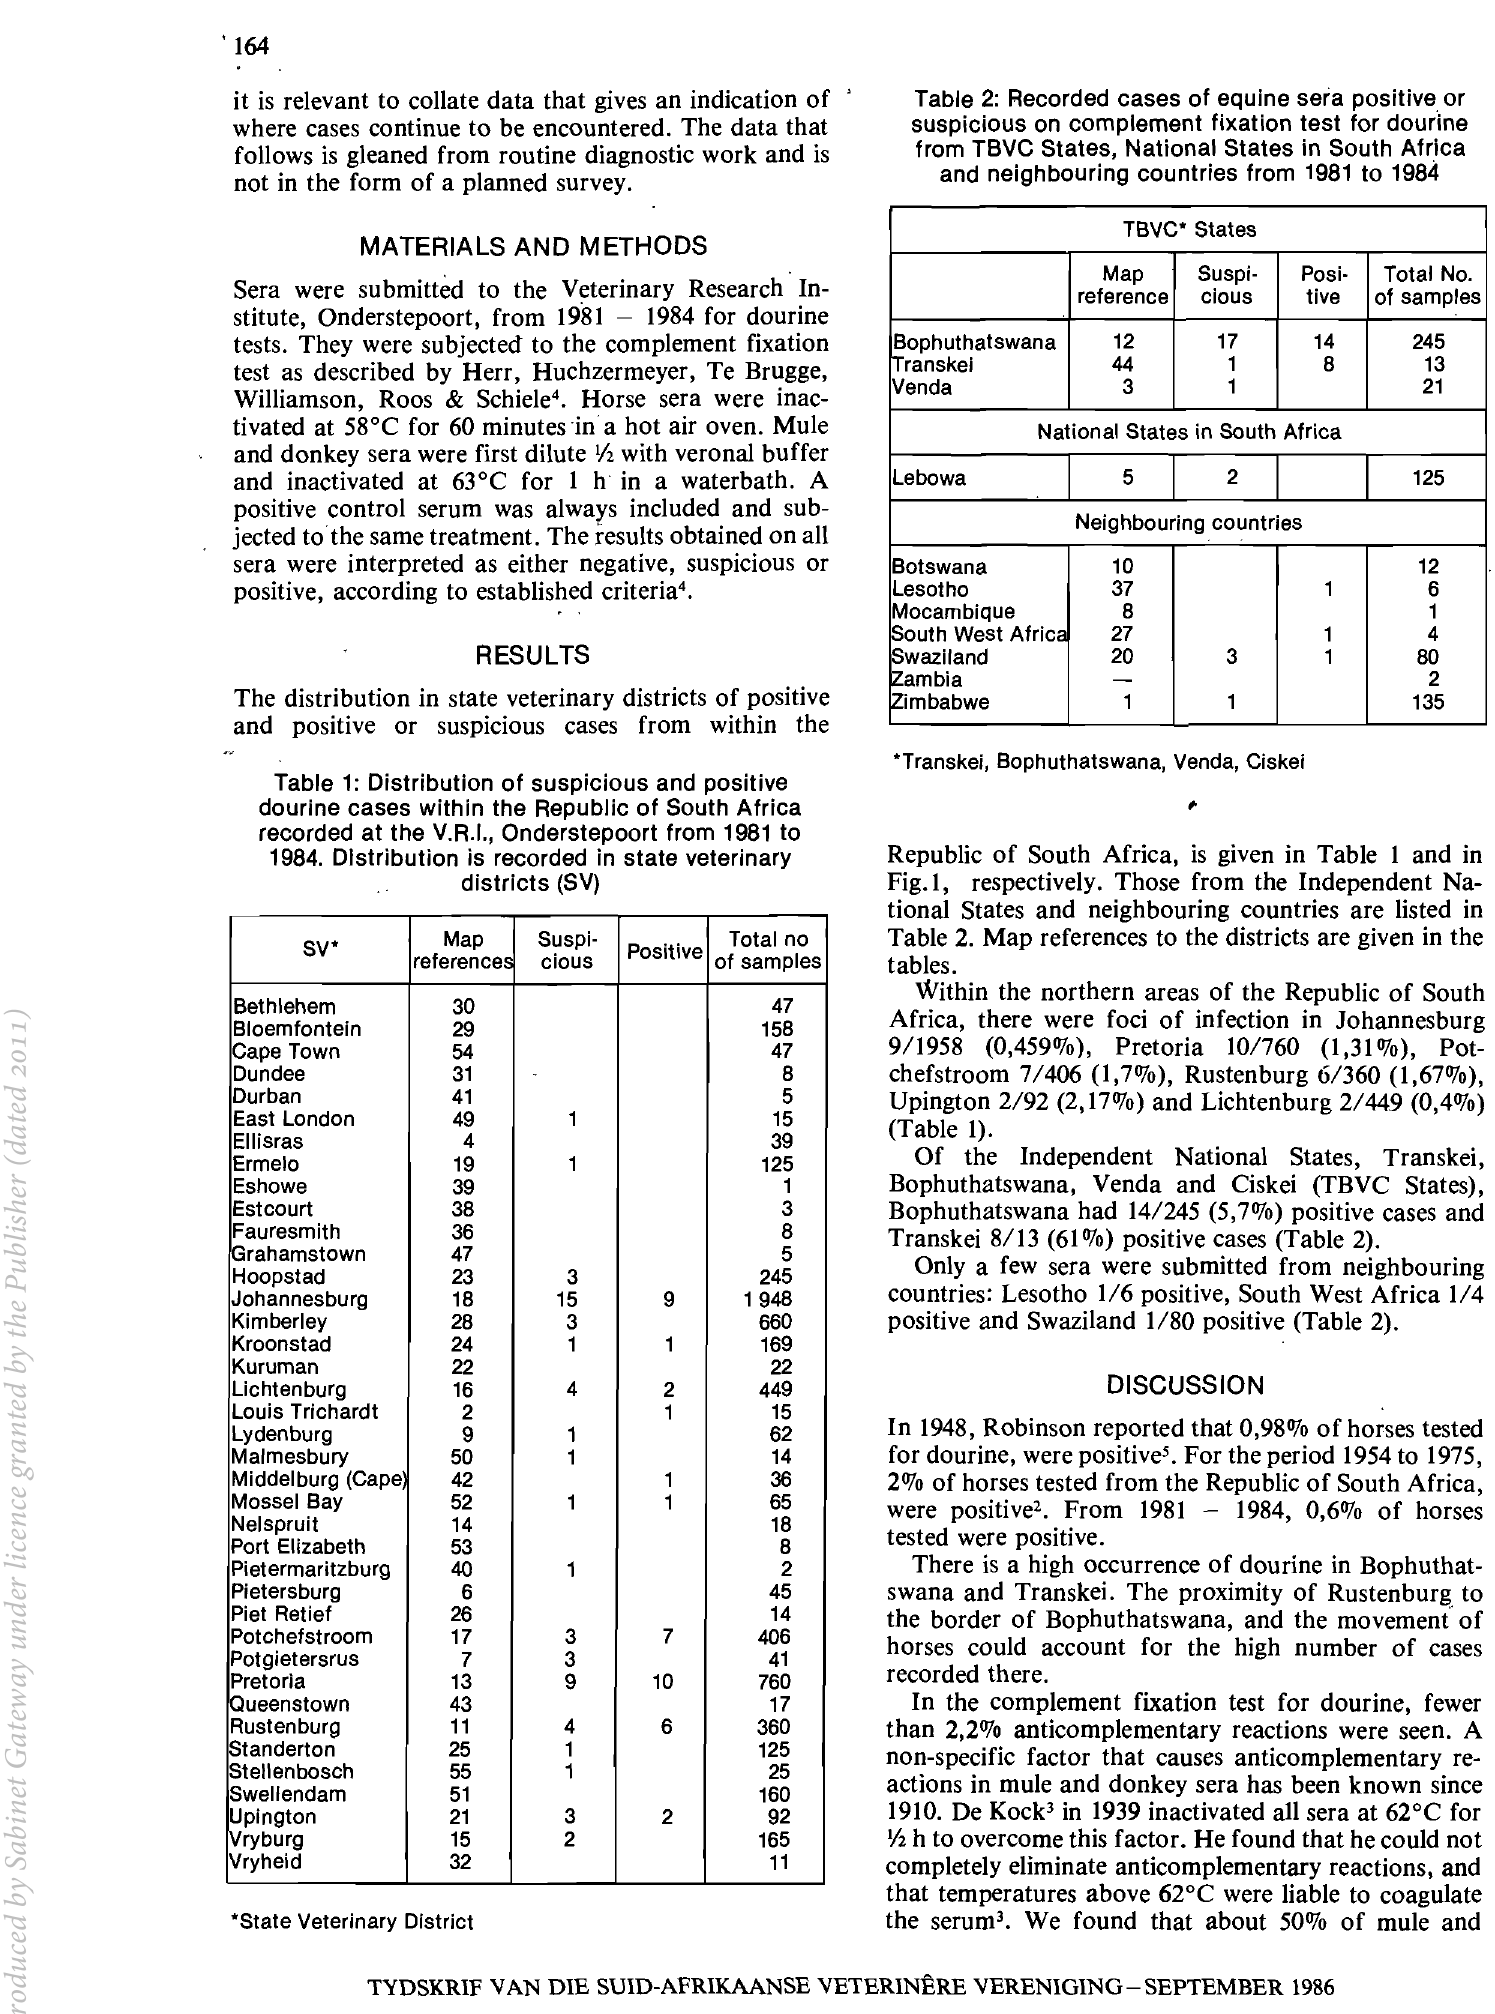
Table 2: Recorded cases of equine sera positive or suspicious on complement fixation test for dourine from TBVC States, National States in South Africa and neighbouring countries from 1981 to 1984